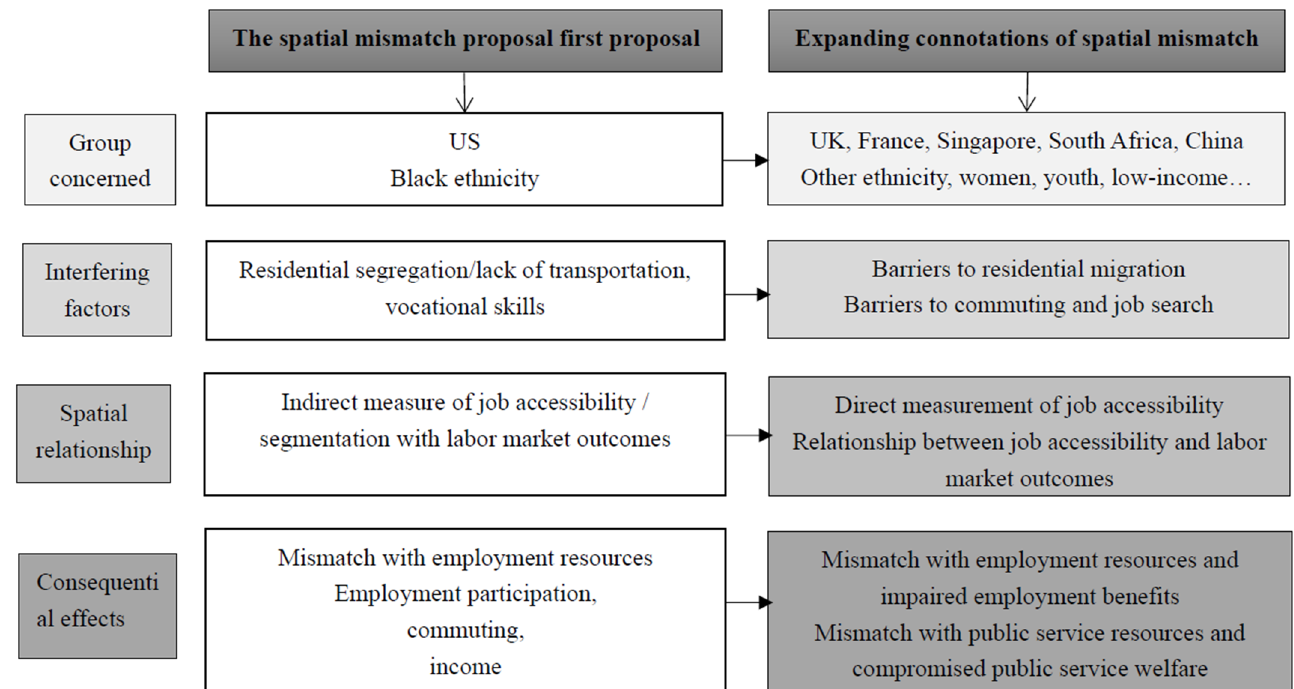
Figure 3. The Connotative Expansion of Spatial Mismatch Theory.